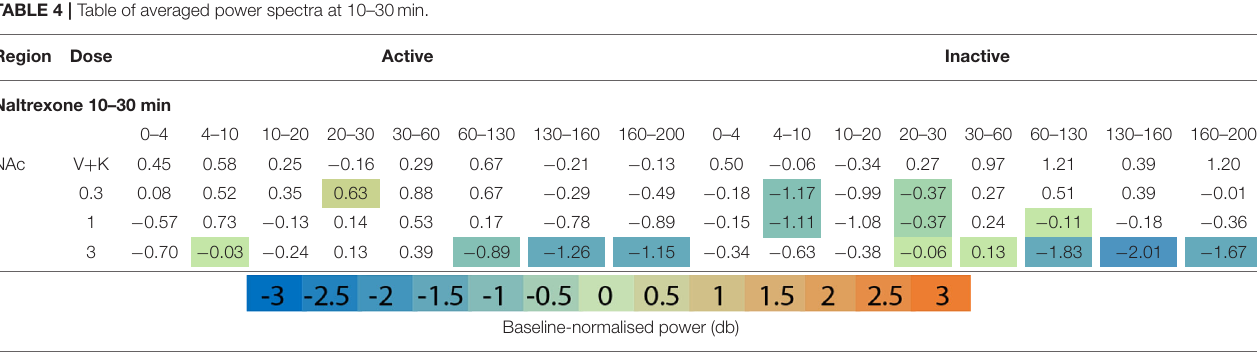
TABLE 4 | Table of averaged power spectra at